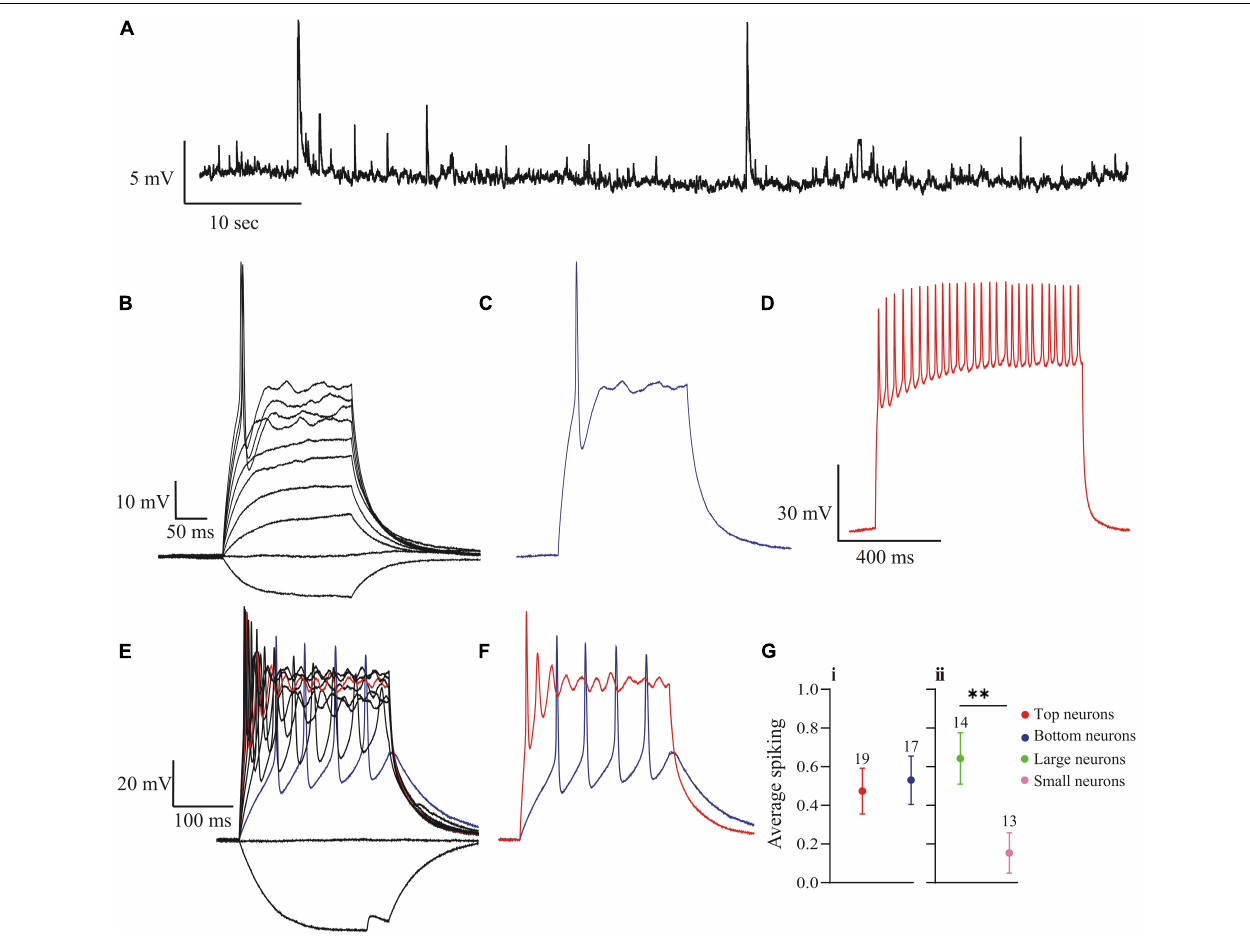
FIGURE 3 | Action potential spiking properties of OB DA neurons. (A) There was no recorded spontaneous action potential activity (generated without stimulus input) in rat OB DA neurons. This recording shows synaptic activity, represented by EPSPs. (B) DA neurons fire a single action potential when stimulated with a sufficiently large depolarizing current. After firing an action potential, they go into depolarization block for the duration of the stimulus. These recordings resulted from incremental 10-pA steps, ranging from –10 to 80-pA. (C) A single trace from Figure 3B , which shows a single action potential generated from an 80-pA stimulus. (D) An example of a trace from a mitral cell (red trace), showing tonic firing in response to a 200-pA stimulus. (E) Some OB DA neurons fire multiple spikes when stimulated with a weaker stimulus (blue trace), but tend to fire a single spike with increasing stimulus strength (red trace). Each voltage trace is a response to incremental 25 pA stimuli, from –25 to 200 pA. (F) Example traces from Figure 3E , which show that a weak stimulus (25 pA in this example, blue trace) produced tonic action potential spiking, while a stronger stimulus (150 pA in this example, red trace) produced decaying spikes followed by a depolarization block. (G) To gauge if DA neurons have different spiking activity based on their glomerular localization and/or neuronal area, dummy variables were assigned to each spiking neuron (0 = no more than one spike at any depolarizing stimulus; 1 = multiple spiker at lower depolarizing stimuli only). There was no significant difference in average number of spikes between neurons based on their glomerular localization ( n = 36, p = 0.7472, Gi ), but there was a significant difference ( n = 27, p = 0.0083**, Gii ) between neurons based on neuronal area. Data represented as mean ±